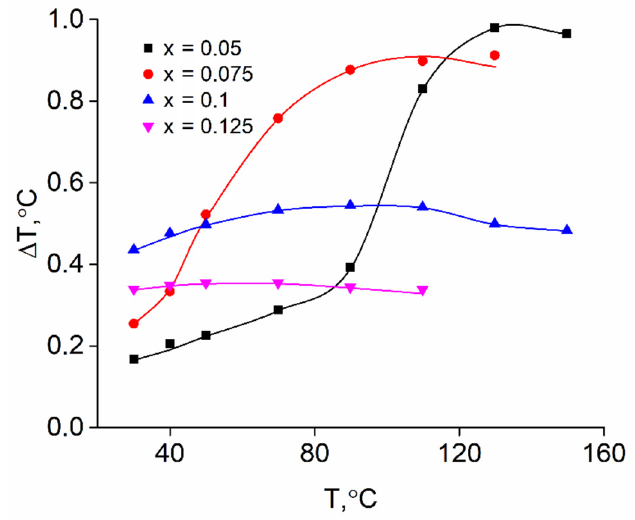
Figure 4. ∆ T(T) for (1 − x)(0.8NBT-0.2BT) − xCT with different concentrations, measured as a result of switching off electric field pulse E = 100 kV/cm.